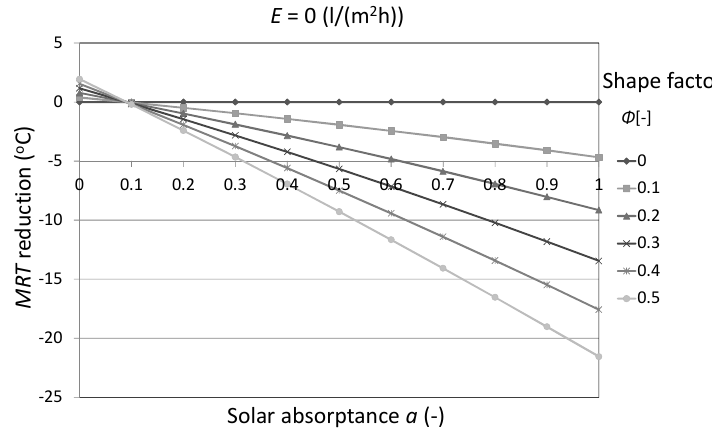
Figure 10. Relationship between the MRT reduction and the solar absorptance a when the evaporation rate E is 0 L/(m 2 h) for different values of the shape factor Φ of the human body.